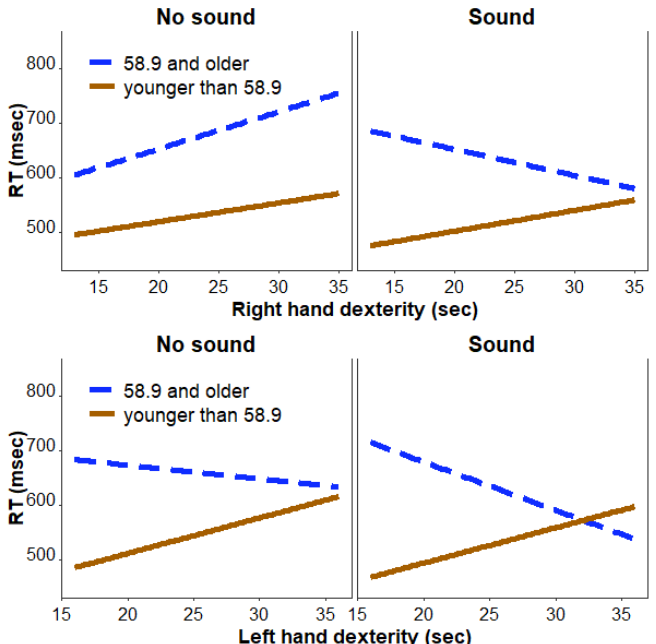
Figure 3. The relationship between hand dexterity and the sound condition in older and younger Figure adults.